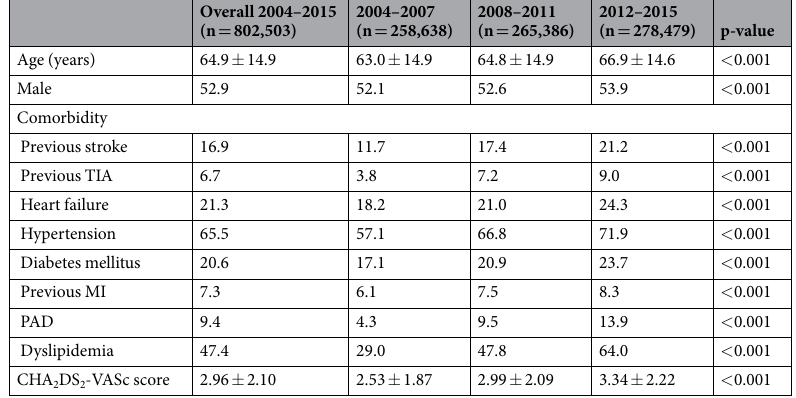
Table 1. Baseline characteristics of incident AF between 2004 and 2015. AF; atrial fibrillation; TIA, transient ischaemic attack; MI, myocardial infarction; PAD, peripheral artery disease. Values are presented as % or mean ± SD.